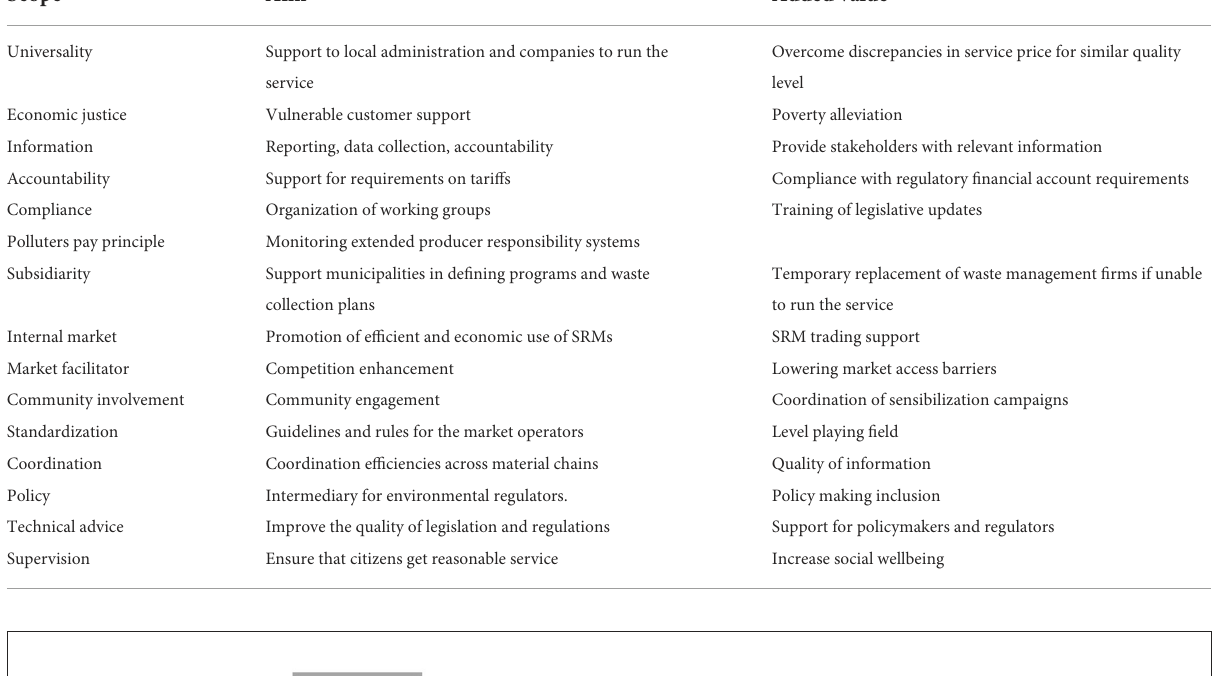
TABLE 1 Prominent activities of a waste management service operator.